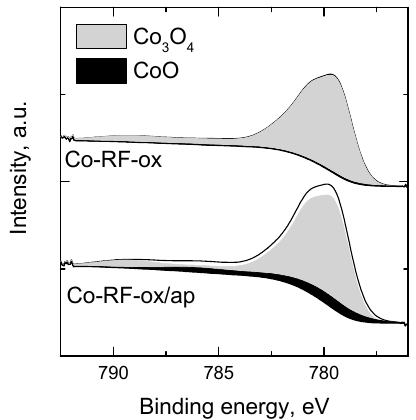
Figure 5. Deconvolution of Co 2p 3 / 2 XPS spectra of the Co-RF-ox / ap and Co-RF-ox catalysts to CoO and Co 3 O 4 contributions (their parameters are taken from Biesinger [31]).